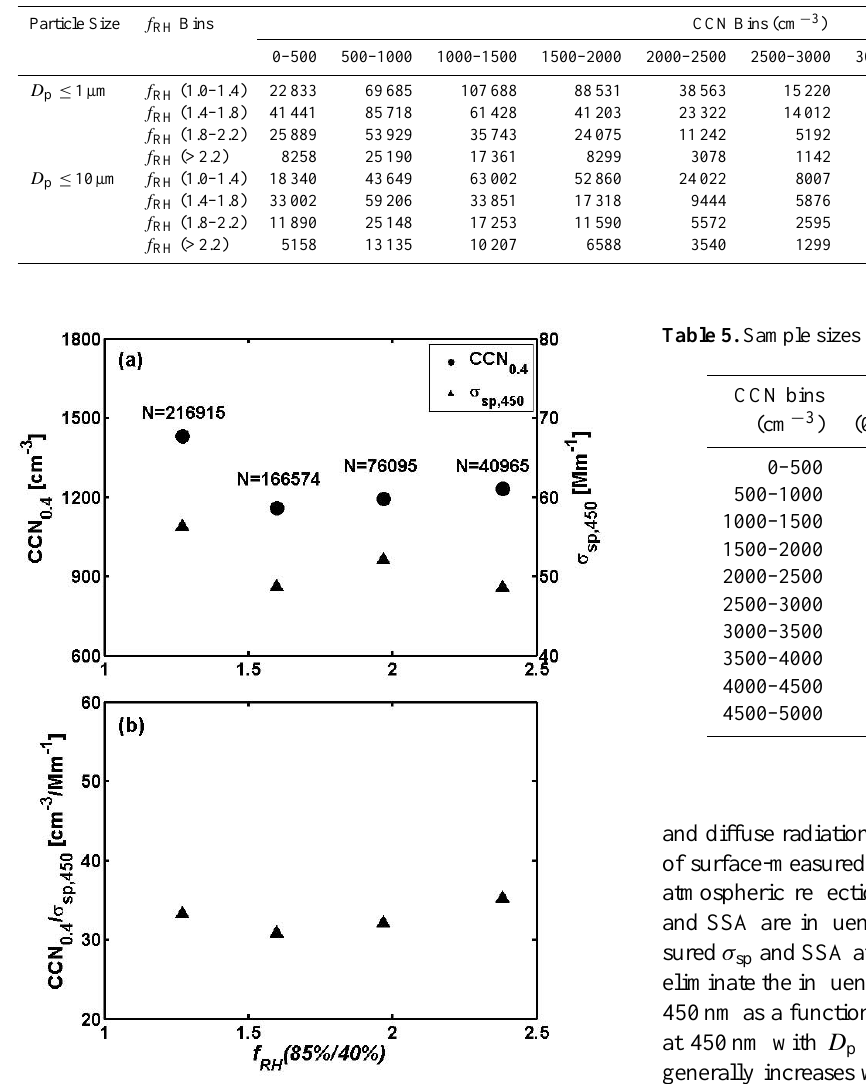
Fig. 6. (a) CCN 0 . 4 concentrations and aerosol scattering coeffi- cients, and (b) their ratio as a function of f RH for dry particles with D P ≤ 10µm. Data are from the SGP site.